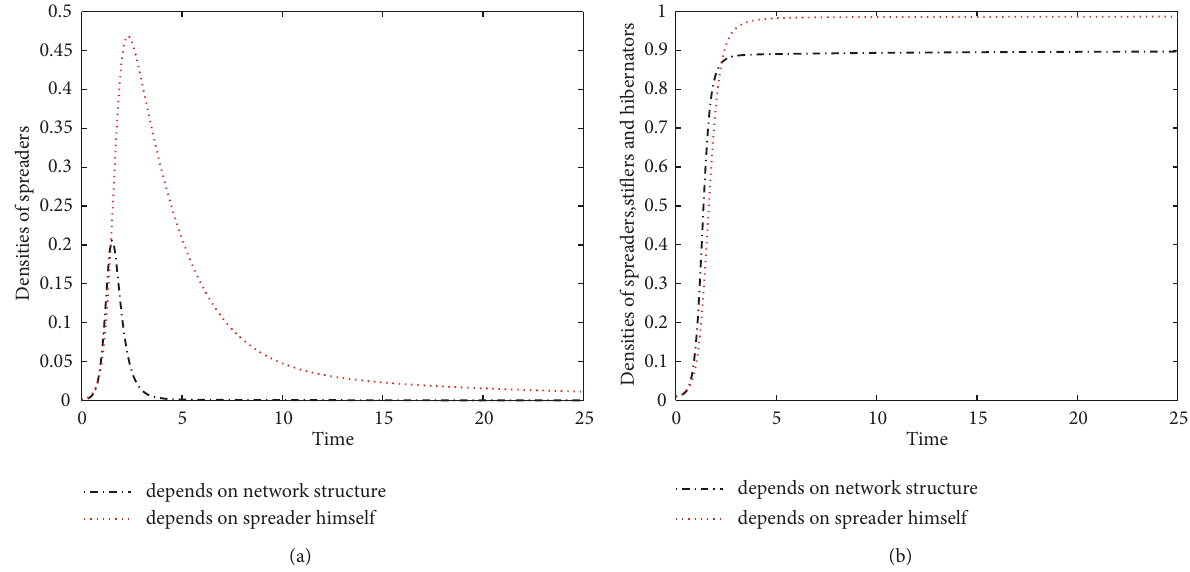
Figure 12: Numerical simulations of (3) with 𝜆 = 0.6 , 𝛽 = 0.3 , 𝛼 = 0.3 , 𝛿 = 0.2 , 𝜉 = 0.1 , and 𝜂 = 0.2 in the networks with the Poisson degree distribution but under different recovery mechanisms. (a) The trajectories of the densities of spreaders. (b) The trajectories of the densities of spreaders, stiflers, and